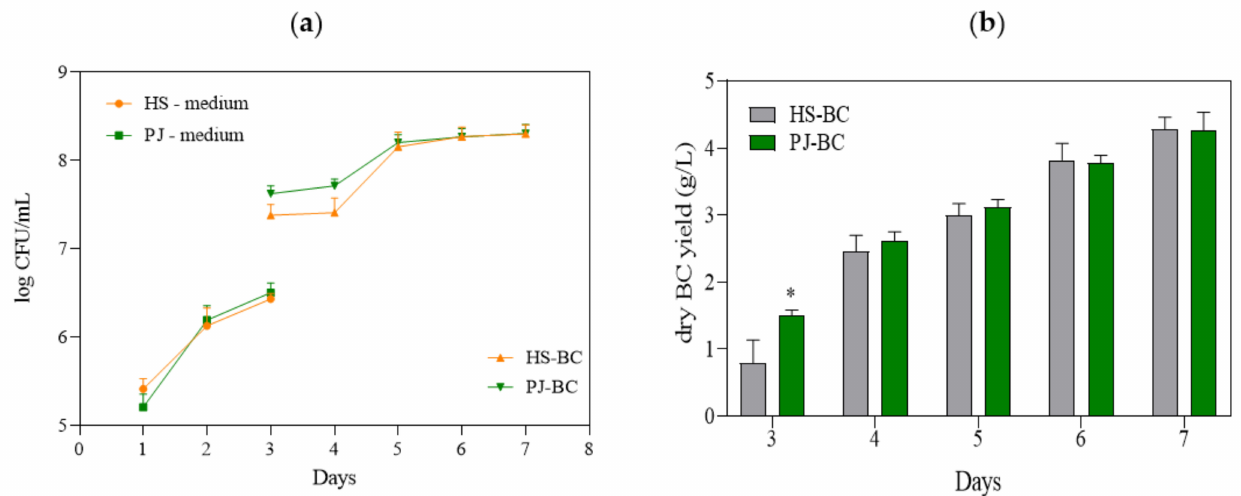
Figure 1. ( a ) Number of K. xylinus ATCC 53524cells in HS and PJ media and in BC pellicles; ( b ) yield of BC synthesized by K. xylinus ATCC 53524in HS and PJ media. Data are presented as a mean ± standard error of the mean (SEM). “*” indicates statistically significant difference between HS-BC and PJ-BC. HS—Hestrin–Schramm medium; PJ—potato juice medium; HS-BC—cellulose synthesized in HS; PJ-BC—cellulose synthesized in PJ.